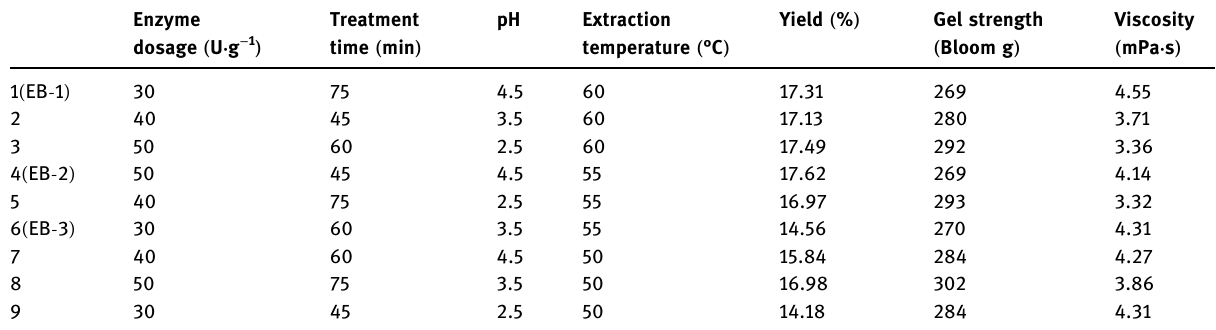
Table 1: Conditions of enzymatic hydrolysis process